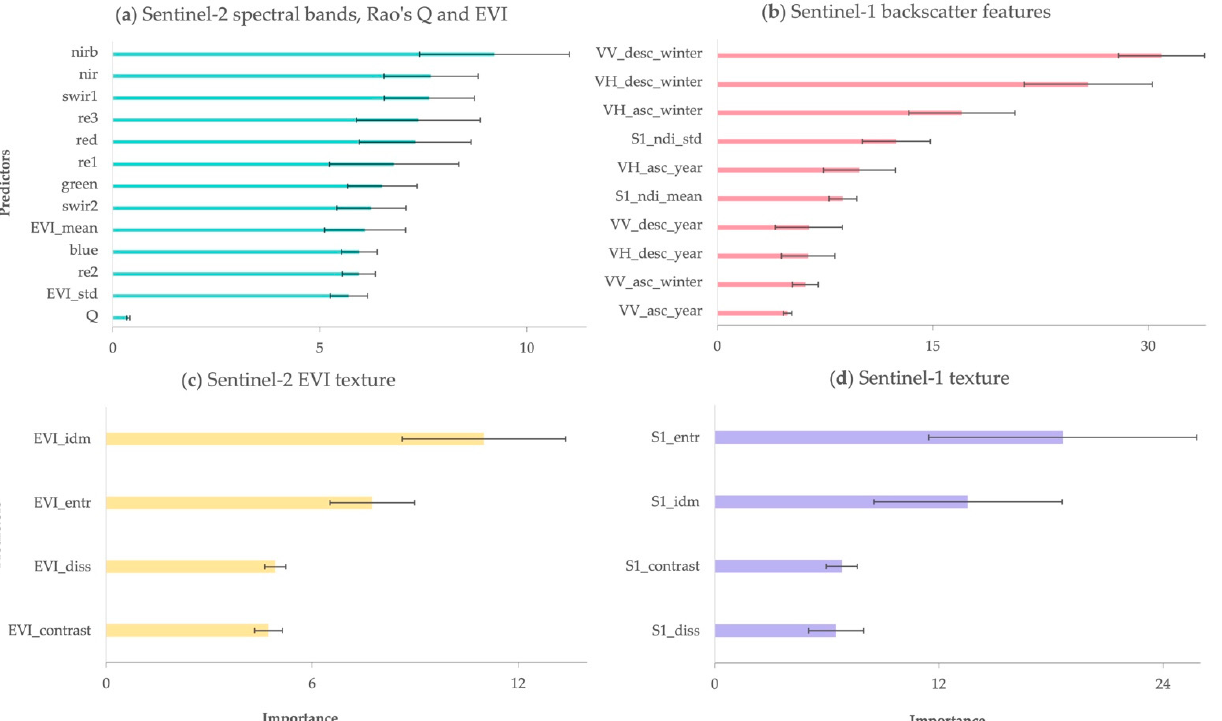
Figure 7. Predictor importance for structural diversity models for the four different feature groups ( a – d ). The error bars indicate the variation in importance across the ten folds where training and validation data have been randomized.